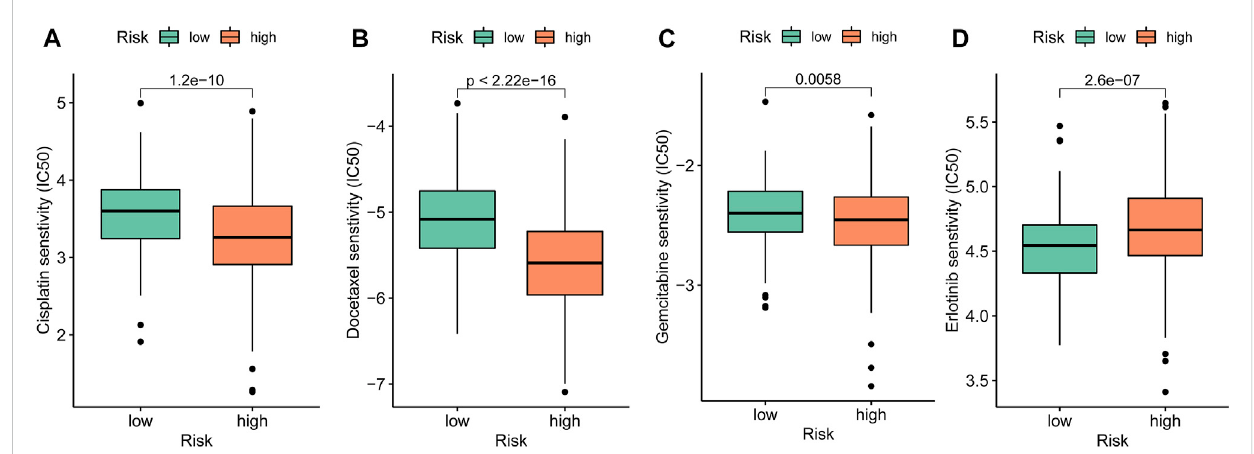
FIGURE 10 Drug sensitivity exploration. (A – D) Chemosensitivity measured by IC 50 of cisplatin, docetaxel, gemcitabine, and erlotinib for anti-tumor